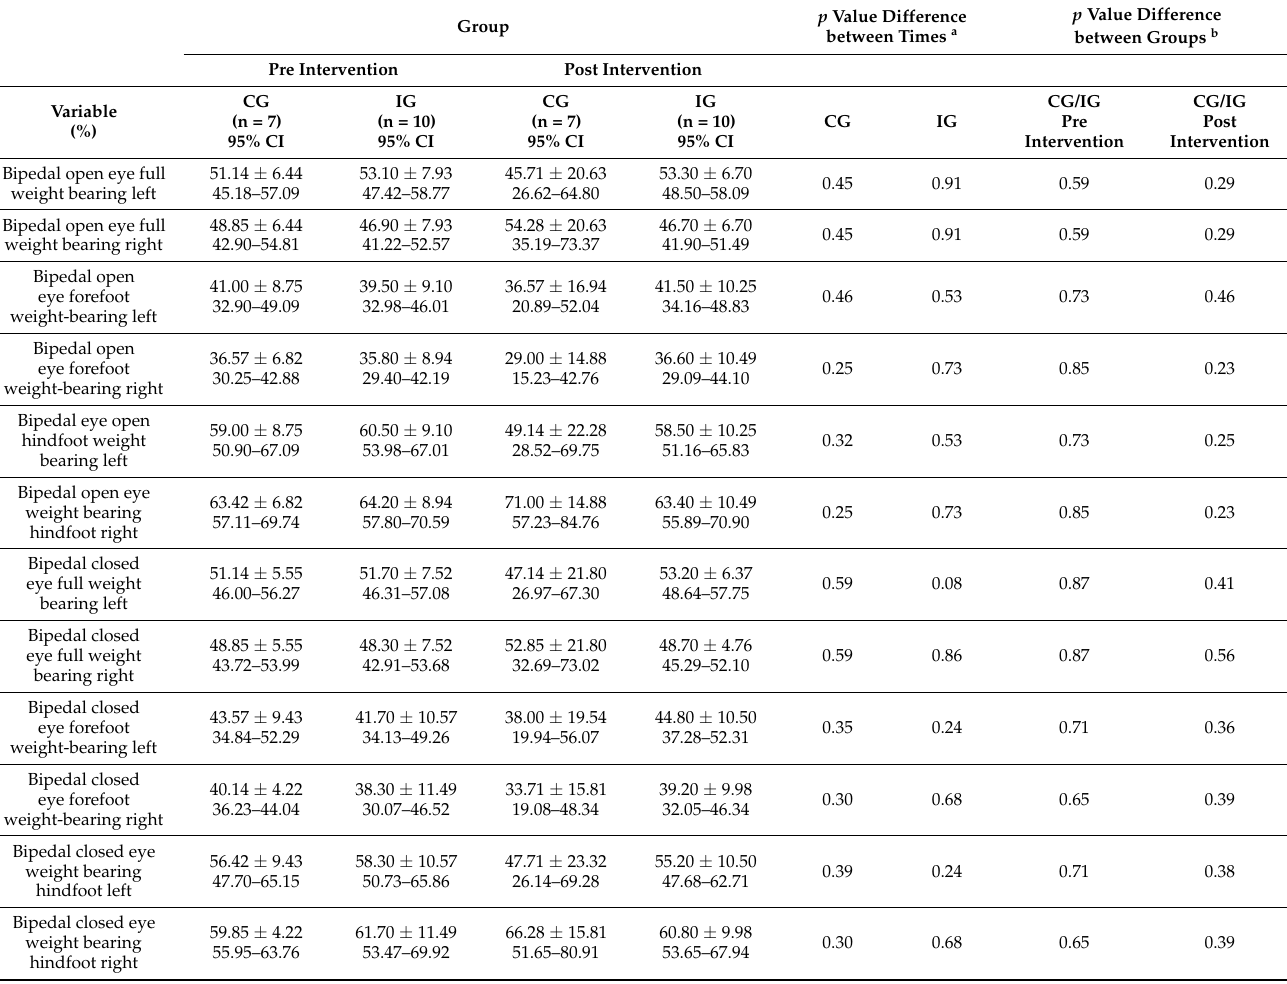
Table 5. Mean values, standard deviation and confidence interval in the comparison of GC and IG for the body sway